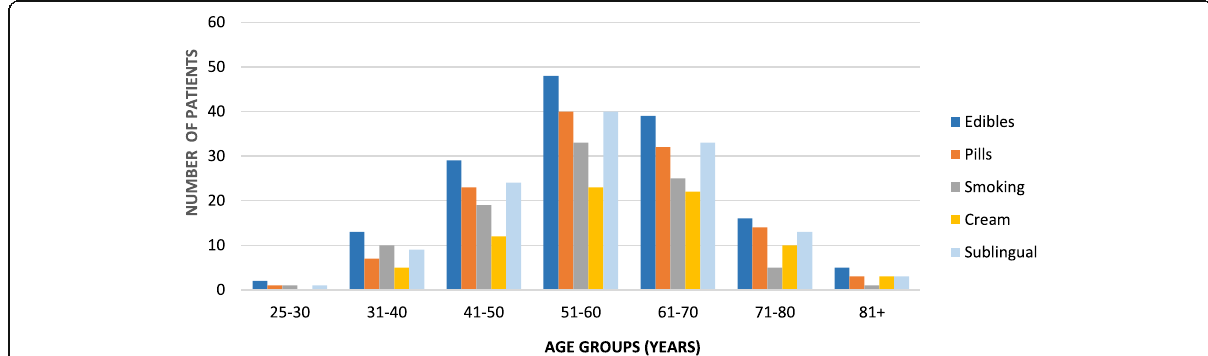
Fig. 6 Responses to question 11 by age group: Preferred form of medical marijuana by age range among those willing to consider it ( n = 204). Respondents were allowed multiple